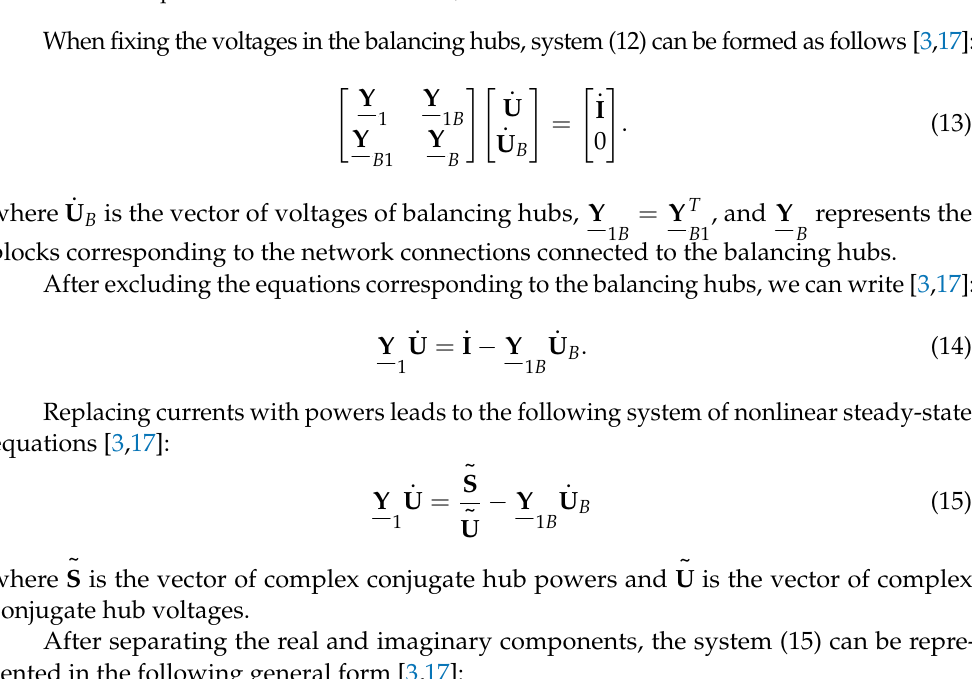
transmission line wires without taking into account their coupling; and M 0 is the matrix determined on the basis of the relation mension r × r .